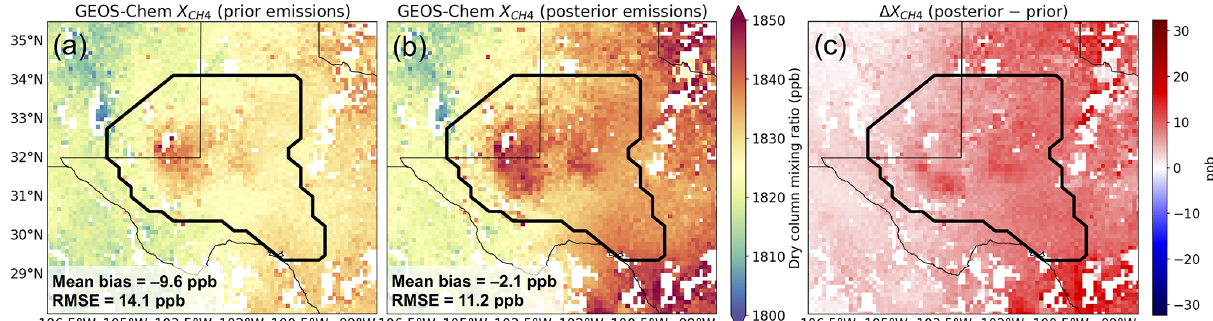
Figure 7. GEOS-Chem simulations of TROPOMI X CH observations for May 2018 with (a) prior emissions and (b) posterior emissions. 4 Panel (c) shows the difference between the two. The contour line shows the Permian Basin selected as the region of interest for the inversion. The insets give the mean bias and RMSE for the region of interest in comparison to the TROPOMI observations in Fig.